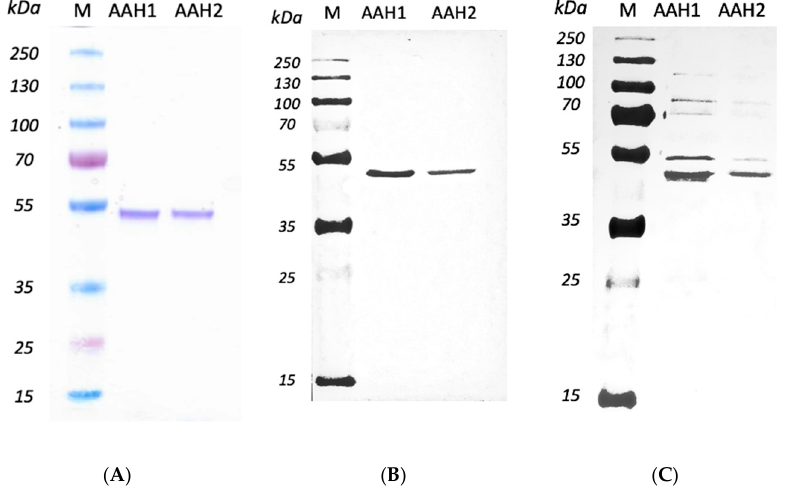
Figure 2. T. gondii aromatic amino acid hydroxylases expressed in this study. SDS–PAGE and Western blots of proteins expressed from AAH1 and AAH2. ( A ) SDS–PAGE of AAH1 and AAH2. ( B ) Monoclonal antibody anti-6xHis Tag. ( C ) Polyclonal antibody anti-TH. Due to the high degree of similarity with TH, recombinant toxoplasmic proteins are recognized by polyclonal antibodies against TH.